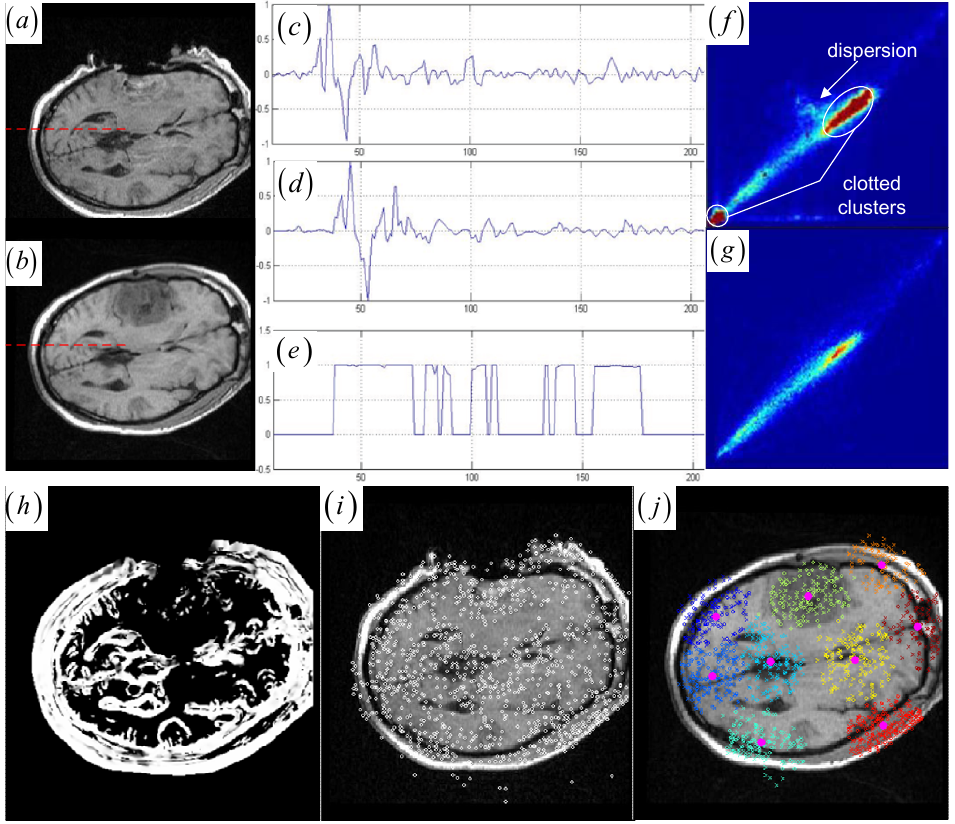
Figure 1. (a)–(b) Intra- and pre-operative MR images with tumor resection. (c)–(d) Gradient value profiles of the lines in (a)–(b), which are marked as dashed lines. (e) JSM value profiles of the lines in (a)–(b). (f) Joint histogram dispersion with two clotted clusters (dark red in pseudo color). (g) The JSM-weighted joint histogram with smoothed compact clusters for (a)–(b). (h) JSM for the two images in (a)–(b) with low JSM values at the tumor resection area. (i) The intra-operative MR image and the circle marked DoG keypoints. (j) The pre-operative image and resultant keypoint clustering with circle marked floating keypoints and cross marked reference keypoints. Different colors mean different